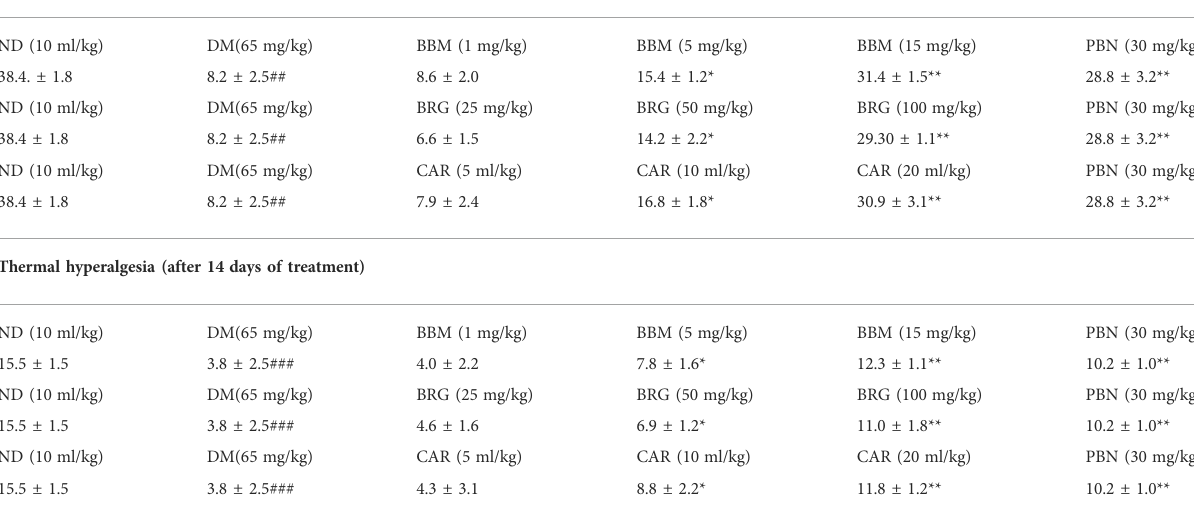
TABLE 2 Effect of berbamine (BBM), bergapten (BRG), carveol (CAR), and pregabalin (PBN) on 14th day on mechanical allodynia and thermal hyperalgesia in streptozotocin (STZ)-induced diabetic neuropathy. Mechanical allodynia (after 14 days of